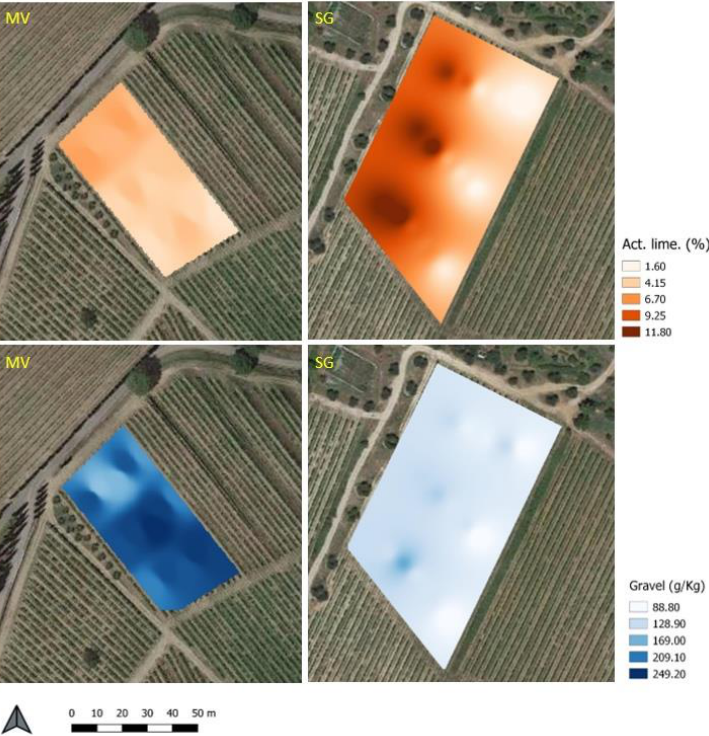
Figure 2. Maps of active limestone and gravel content of MV and SG experimental fields.